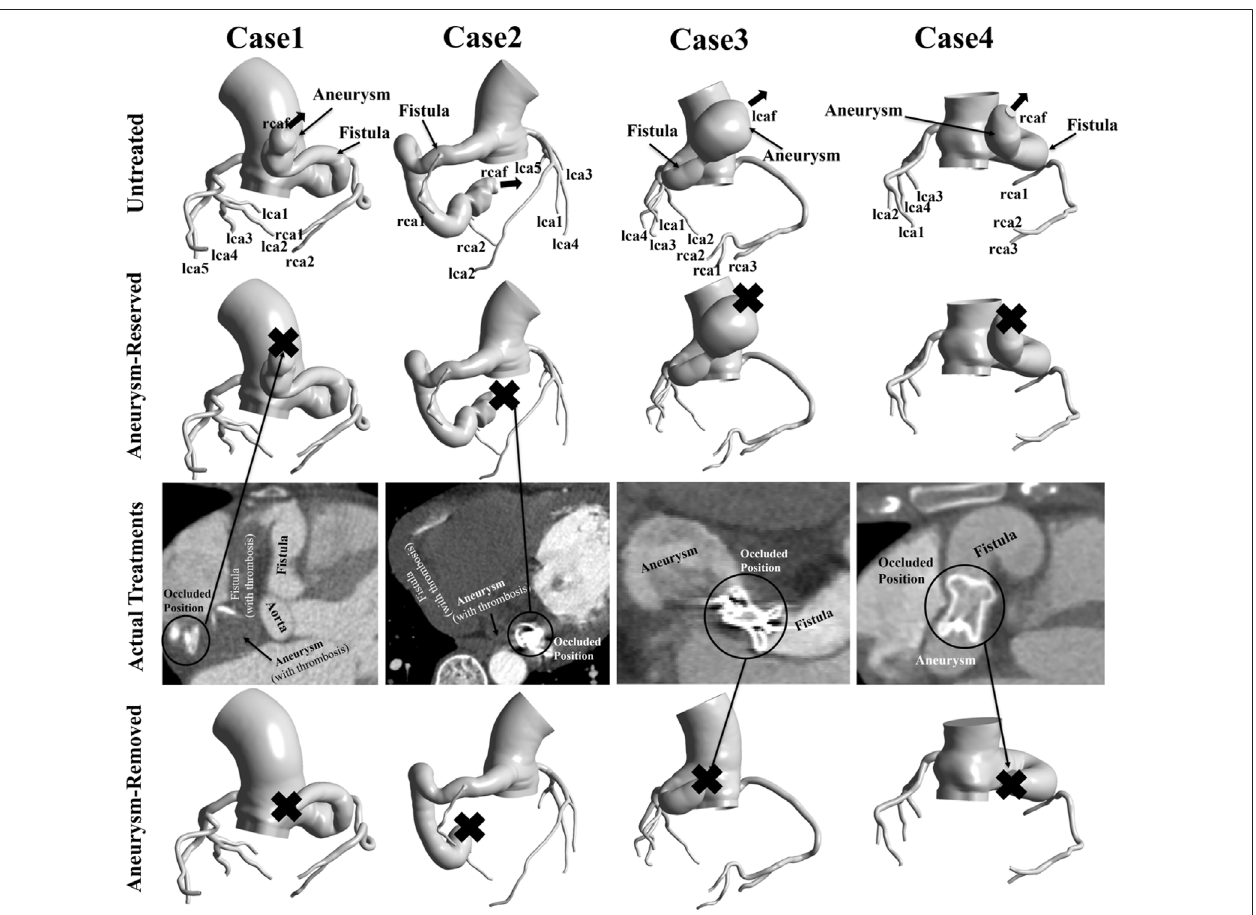
FIGURE 1 | Patient-speci fi c models reconstructed from CTA data. “ Aneurysm-reserved model ” and “ Aneurysm-removed model ” referred to the proximal or distal occlusions. In actual treatments, case1 and case2 had distal occlusions, while case3 and case4 had proximal occlusions. “ X ” indicates the occluded position of the model.